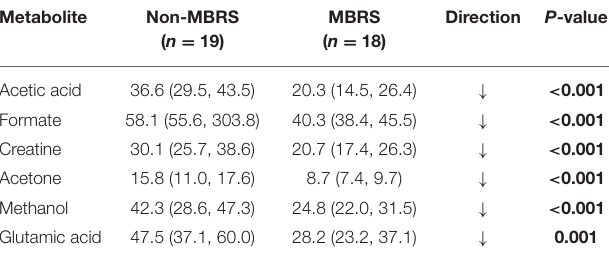
TABLE 3 | Military personnel metabolite